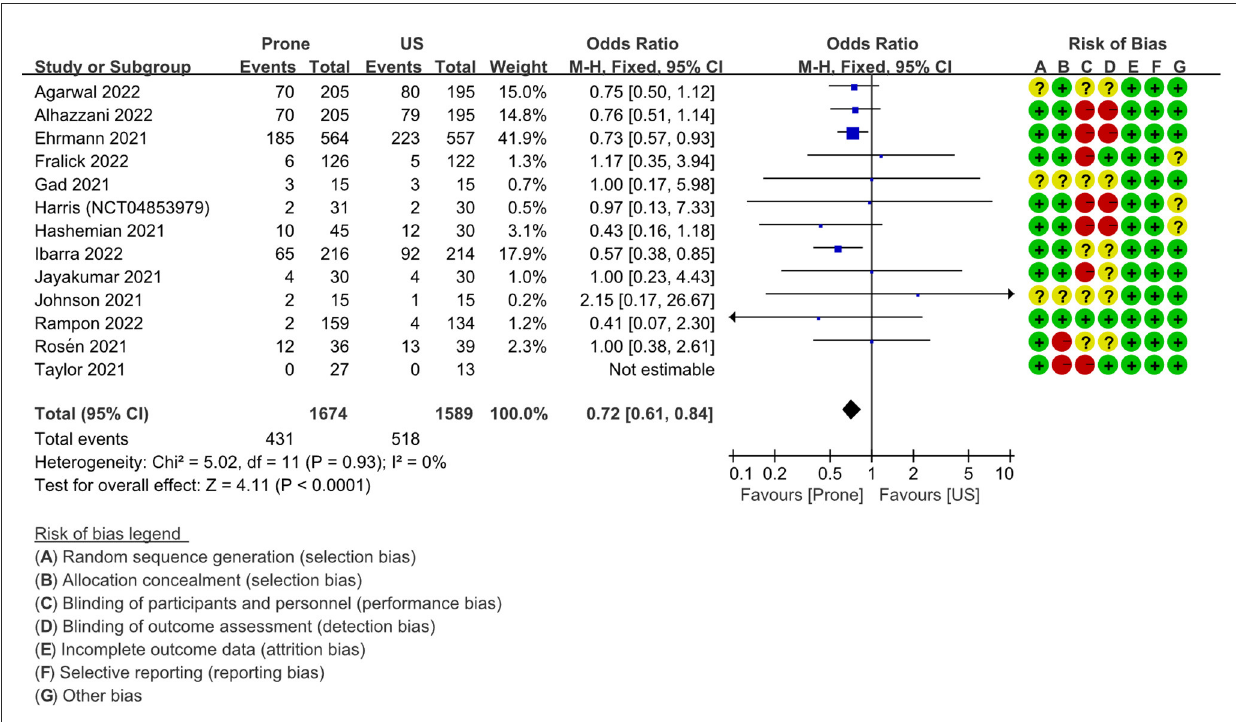
FIGURE4 Primary outcome: forest plot of intubation rate in fixed effects model. US, usual care; M–H, Mantel–Haenszel; CI, confidence interval.